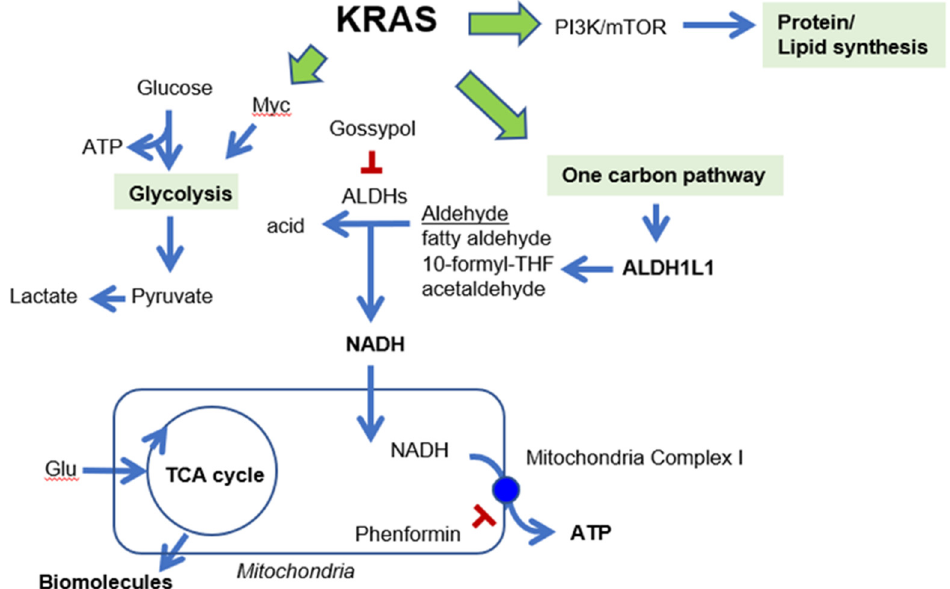
Figure7. KRASpromotesglycolysis, proteinandlipidsynthesisandonecarbonpathway[23]. Induction Figure 7. KRAS promotes glycolysis, protein and lipid synthesis and one carbon pathway [23]. of ALDH1L1 by KRAS promotes the one-carbon pathway in NSCLC. Gossypol and phenformin reduces Induction of ALDH1L1 by KRAS promotes the one-carbon pathway in NSCLC. Gossypol and NADH and ATP production, phenformin reduces NADH and ATP production, respectively.